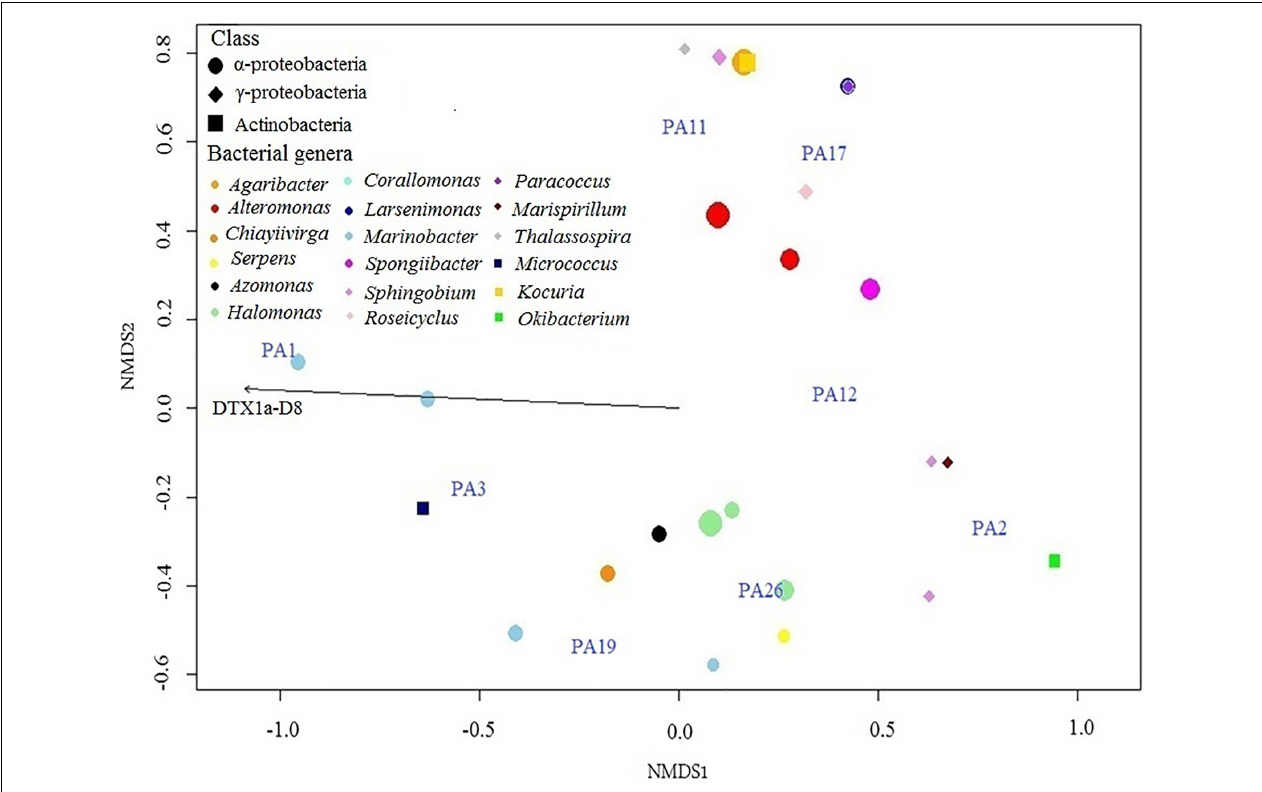
FIGURE 4 | NMDS plot based upon a Bray–Curtis matrix of the distribution of clones of the Prorocentrum lima species complex (PLSC) in relation to the abundance of their associated isolated bacterial genera and DSP toxin composition in culture. The scale of the axes is arbitrary as is the orientation of the plot, with closeness of the clustered elements indicating the degree of similarity and association. The symbol shape denotes the bacterial class; color indicates genera; and size denotes abundance. Vector length indicates magnitude and correlation of the toxin with the Prorocentrum clones and their isolated associated bacteria.